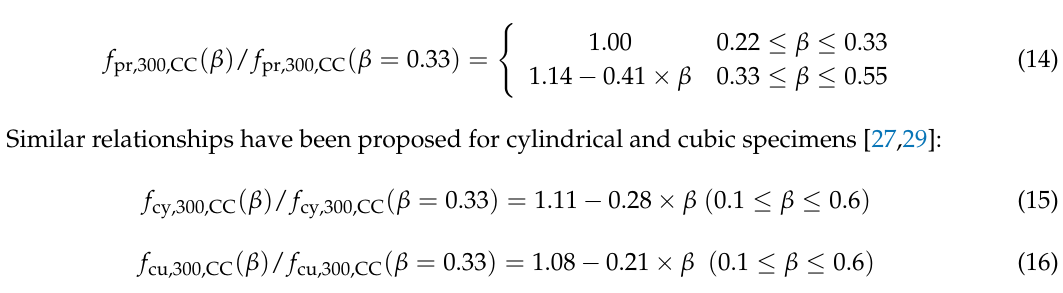
Table 7. Experimental results of specimens in Group 6.